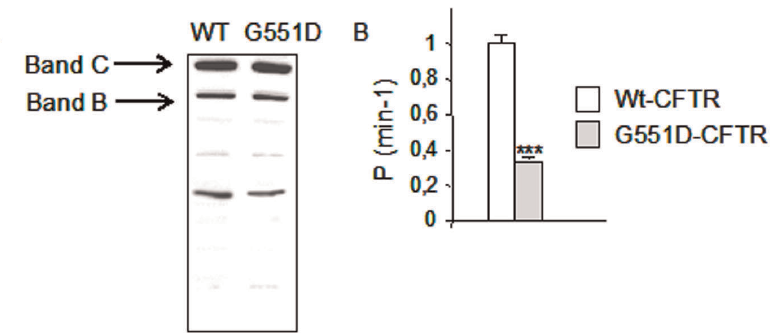
Figure 1. Validation of the cell model. A, Wt-CFTR and G551D-CFTR expression in Hela cells. Example of western blot showing the mature fully glycosylated CFTR and core-glycosylated CFTR labeled as Band C (170 kDa) and Band B, respectively. B, Study of the cyclic AMP-induced I 2 efflux from Wt-CFTR (n=3) and G551D-CFTR (n=3) using SPQ experiments. The halide permeability (p) is the rate of SPQ dequenching. The graphs show a deeply decreased activity in G551D-CFTR expressing cells. Data are the means 6 S.E.M., ***: p ,